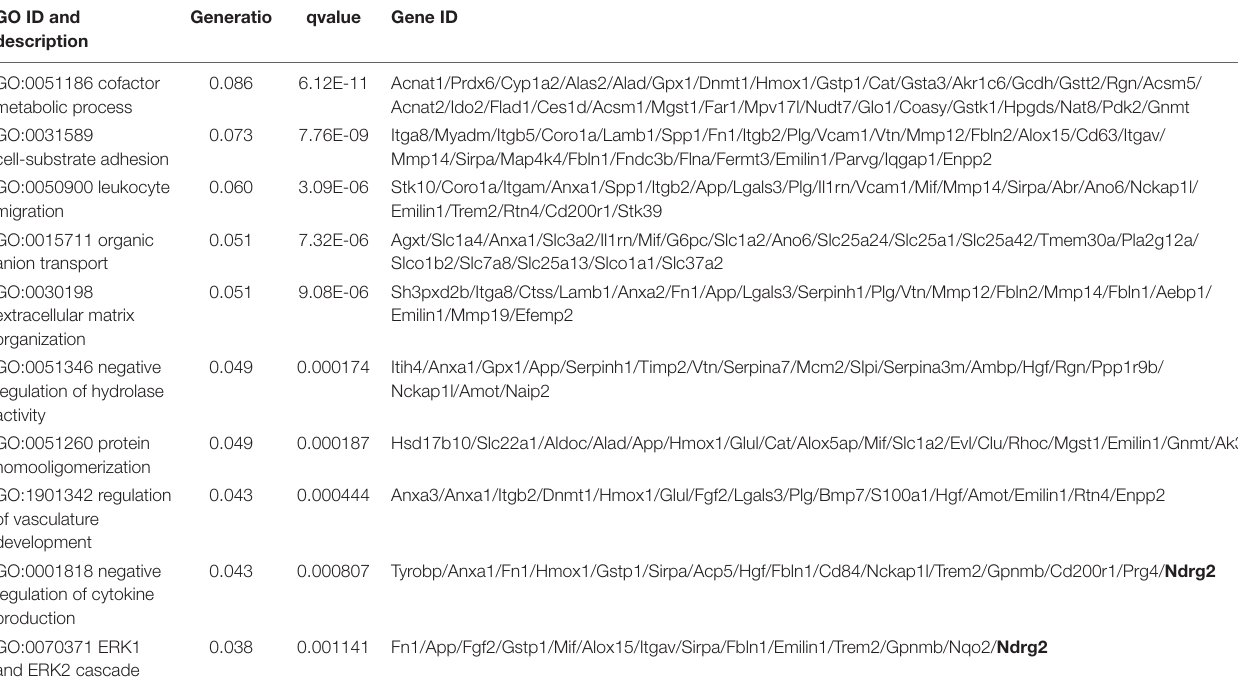
TABLE 1 | List of genes enriched in the Top 10 GO terms.